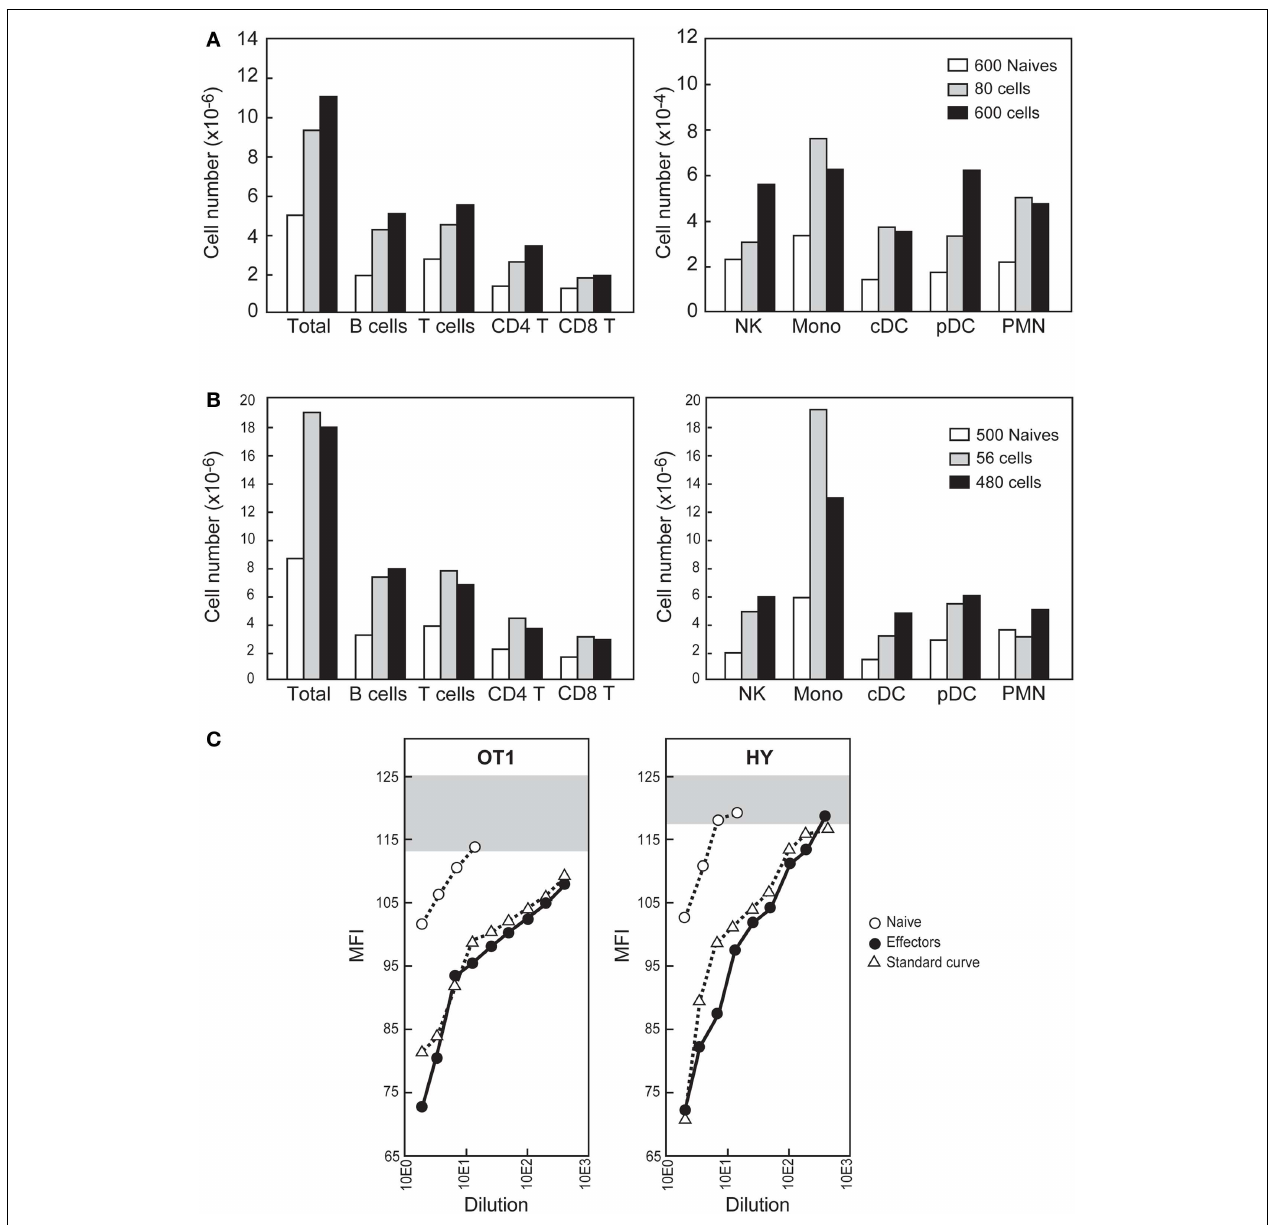
OT-1Tg cells. (B) Mice injected with HYTg cells. Similar results were obtained after injection of P14Tg cells. (C) The BRLNs were injected with 500 naïve cells, 80 OT-1 effectors or 56 HY effectors. Results show of S1P amounts in LN lysates 16h later, compared with known amounts of a synthetic S1P. Gray bars represent the Flag-S1P1 expression ofWEHI231 incubated with medium alone. Results are representative of the seven experiments we